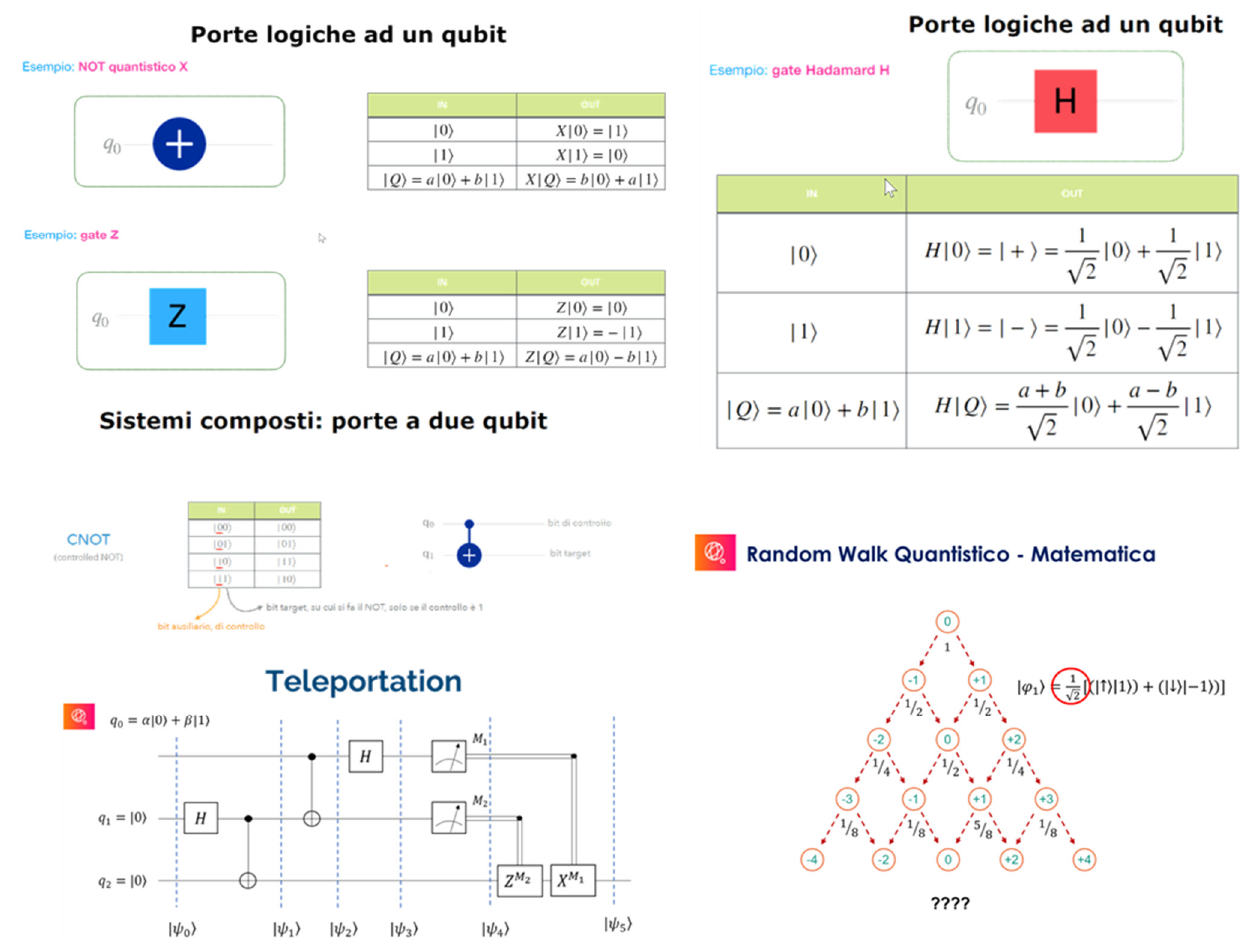
Figure A1. Examples from the specific path “Quantum computing”. Screenshots of the slides used during the lecture. Top : single-qubit gates. Left middle : two-qubit gates. Left bottom : teleportation protocol. Right-bottom : one step of the mathematical description of the quantum random walk protocol.